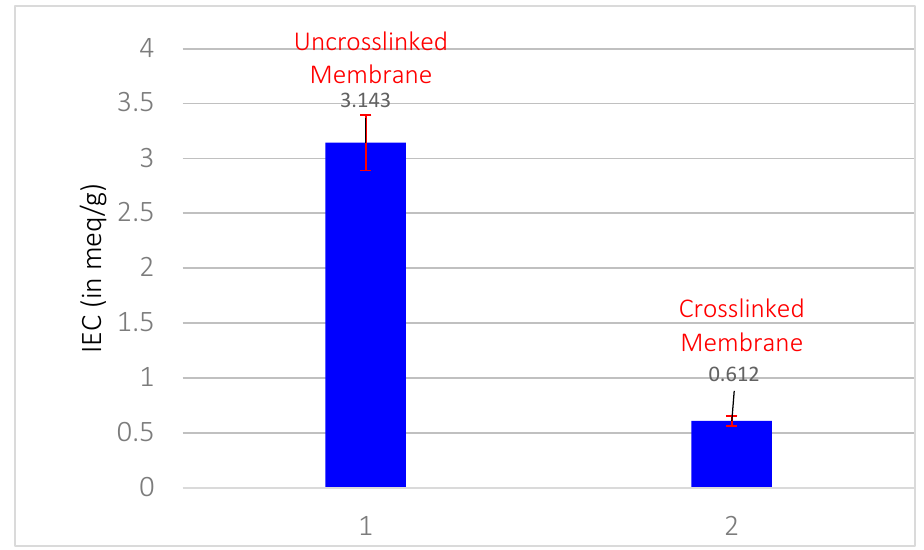
Figure 10. Mechanical Strength of the various prepared membranes.